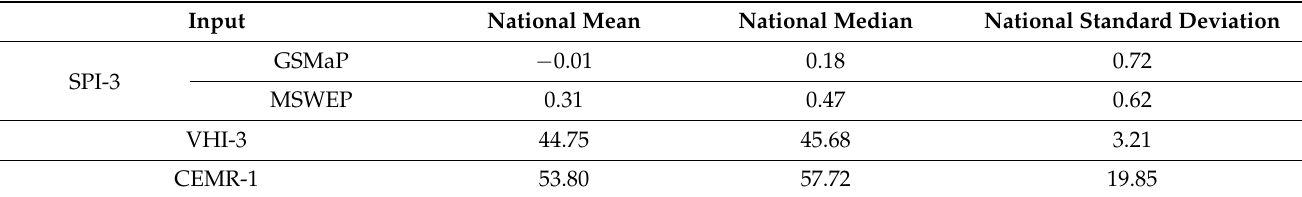
Table 2. Mean, median and standard deviation for nationally averaged SPI-3, VHI-3 and CEMR-1 for the month ahead.